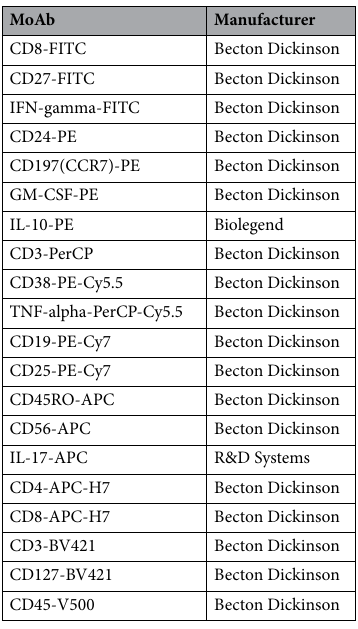
Table 3. Monoclonal antibodies (MoAb) used in the study. GM-CSF granulocyte/macrophage-colony stimulating factor, IFN interferon, IL interleukin, TNF tumor necrosis